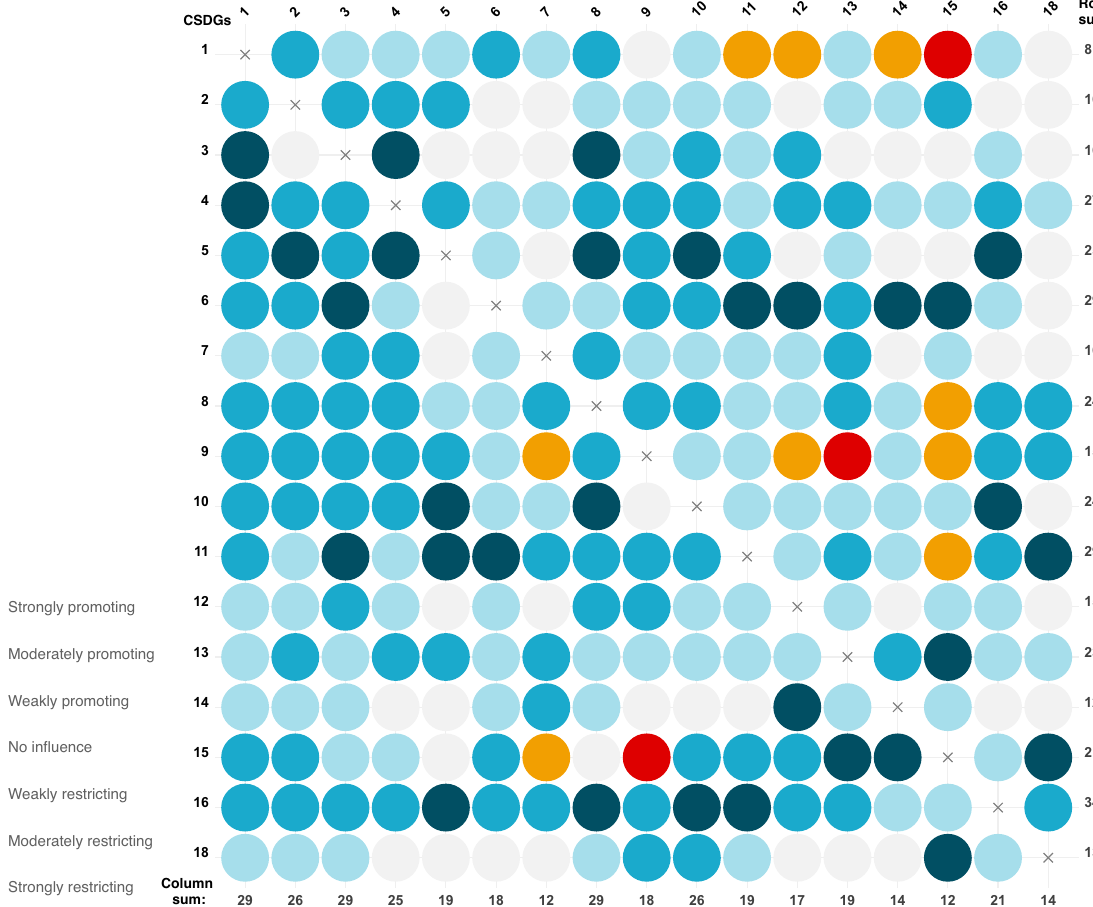
Fig. 1 Cross-impact matrix of the 17 Cambodian Sustainable Development Goals. Color according to scale. The row sum implies the net in fl uence of the goal on the network, and the column net sum show the how much the goal is in fl uenced by all other goals in the network. Cambodia Sustainable Development Goals 1 no poverty, 2 zero hunger, 3 child health, 4 quality education, 5 gender equality, 6 clean water and sanitation, 7 affordable and clean energy, 8 decent work and economic growth, 9 industry, innovation and infrastructure, 10 reduced inequalities, 11 sustainable cities and communities, 12 responsible consumption and production, 13 climate change, 14 life below water, 15 life on land, 16 peace, justice and strong institutions, and 18 mine/ERW free. The underlying data can be found in Supplementary Data